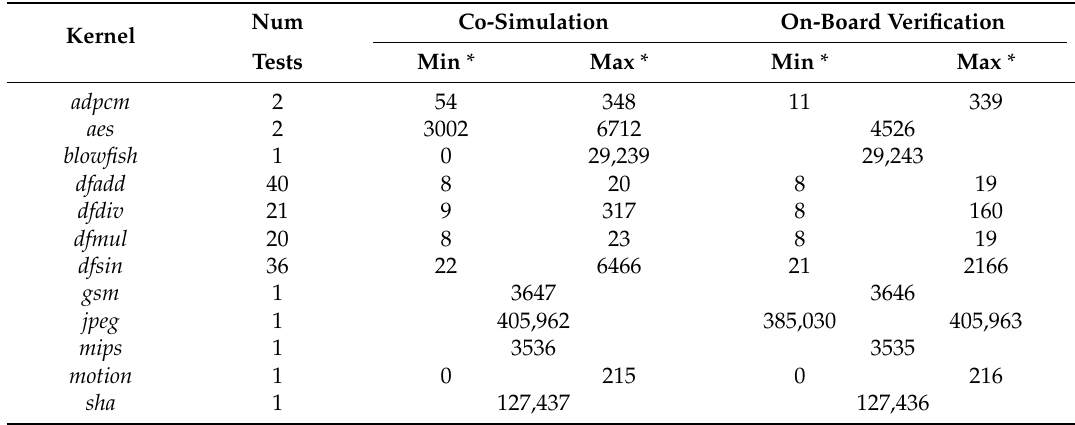
Table 1. Latency statistics from CHStone kernels.